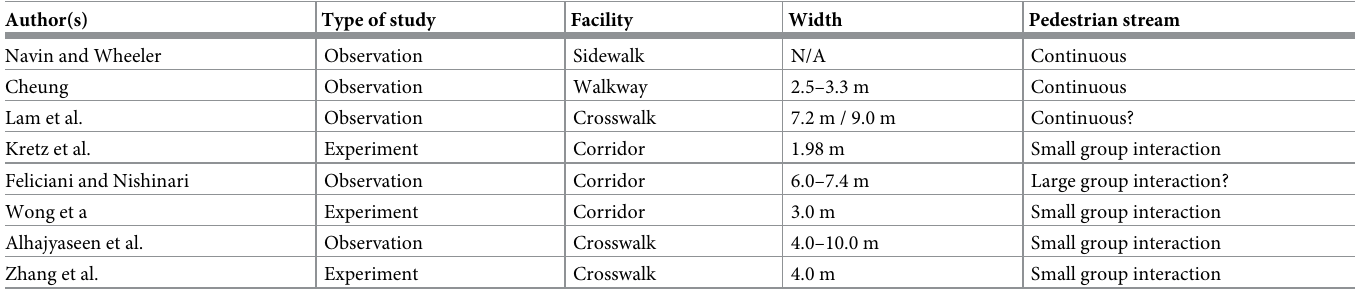
Table 2. Comparison between the different studies. Continuous pedestrian stream indicates a situation in which people continuously flow through the facility, while small group interaction is the case in which two groups limited in size pass each other’s (as in the case of signalized crosswalks). Author(s)